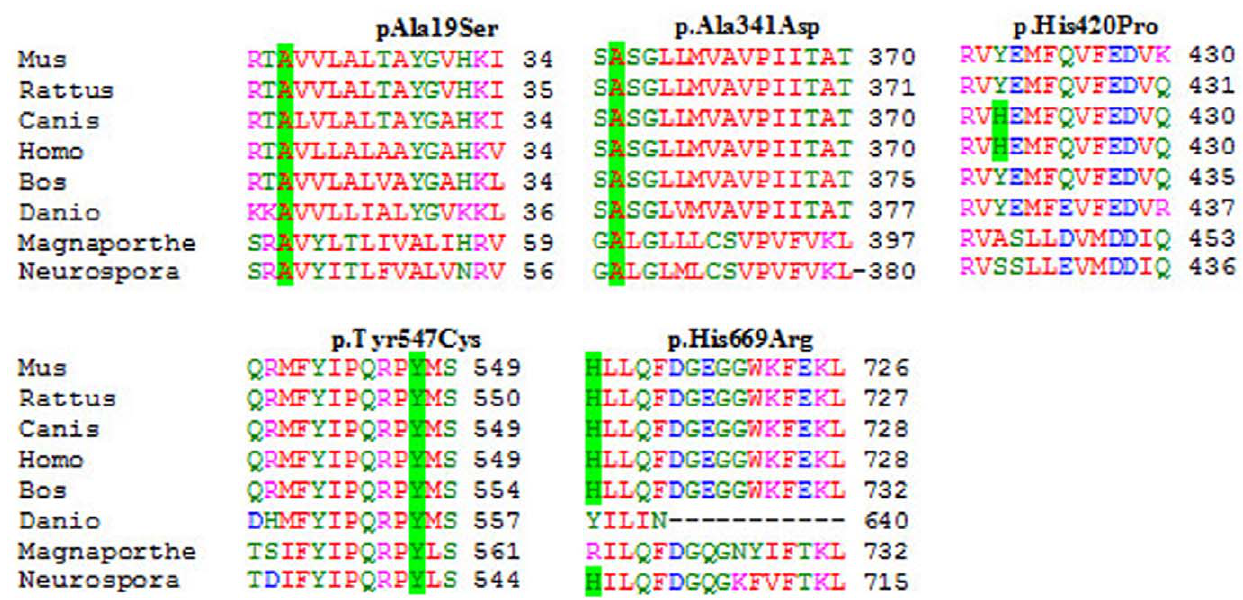
doi:10.1371/journal.pone.0052635.g005